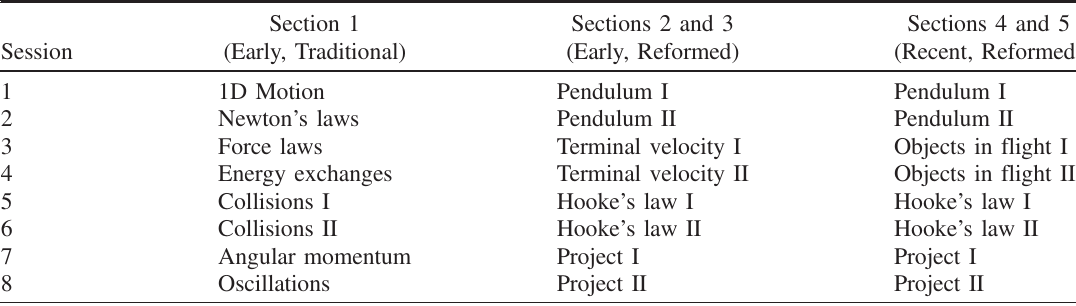
TABLE III. Topics of lab activities for each section analyzed in this study. Sections 2 through 5 (all reformed labs) covered similar topics during the same sessions of the semester, while section 1 (the traditional lab) completed distinct